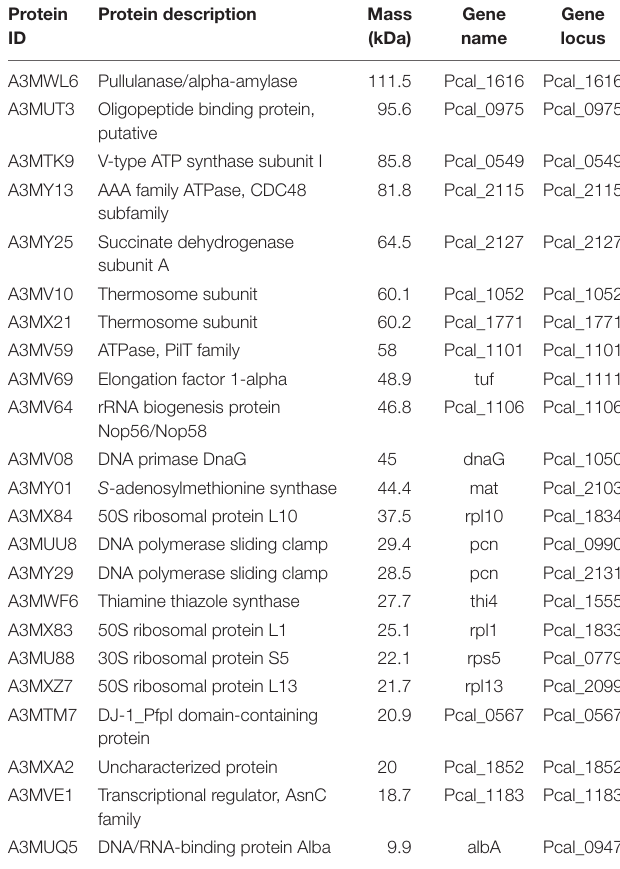
TABLE 1 | Proteins identified by mass spectrometry from isolated chromosomes of Thermoplasma acidophilum . Protein Protein description Mass ID